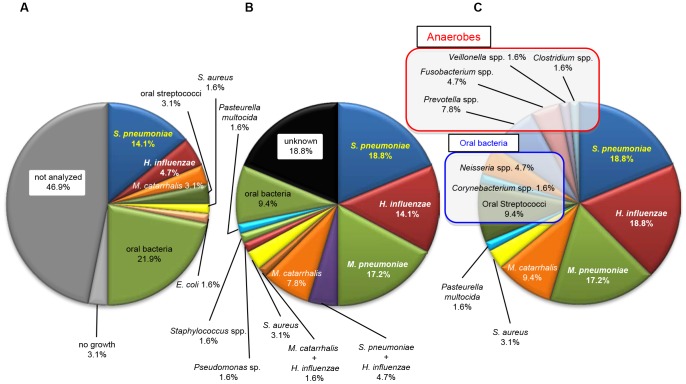
Percentage of detected bacteria by sputum and bronchoalveolar lavage cultivation and the molecular method.The percentage of samples in which bacteria were detected by conventional cultivation of sputum (A), bronchoalveolar lavage (BAL) samples (B) and the molecular method using the 16S rRNA gene (C). The molecular method detected causative bacteria in all BAL samples, and there were considerably higher ratios of oral streptococci and anaerobes detected using the molecular method in comparison to culture methods. “Not analyzed” means that the patients could not produce any sputum for the sputum examination at the time of hospital admission.